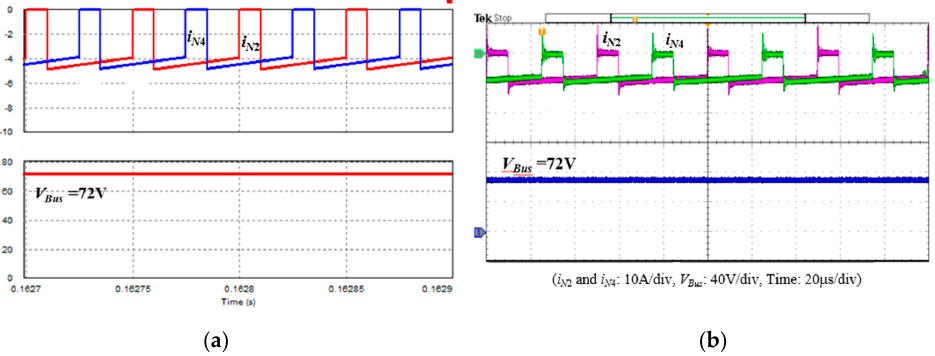
Figure 19. The waveform of the secondary-side currents of the coupled inductor and DC-bus voltage in the UC discharging mode with D d = 0.2: ( a ) simulated and ( b ) experimental.